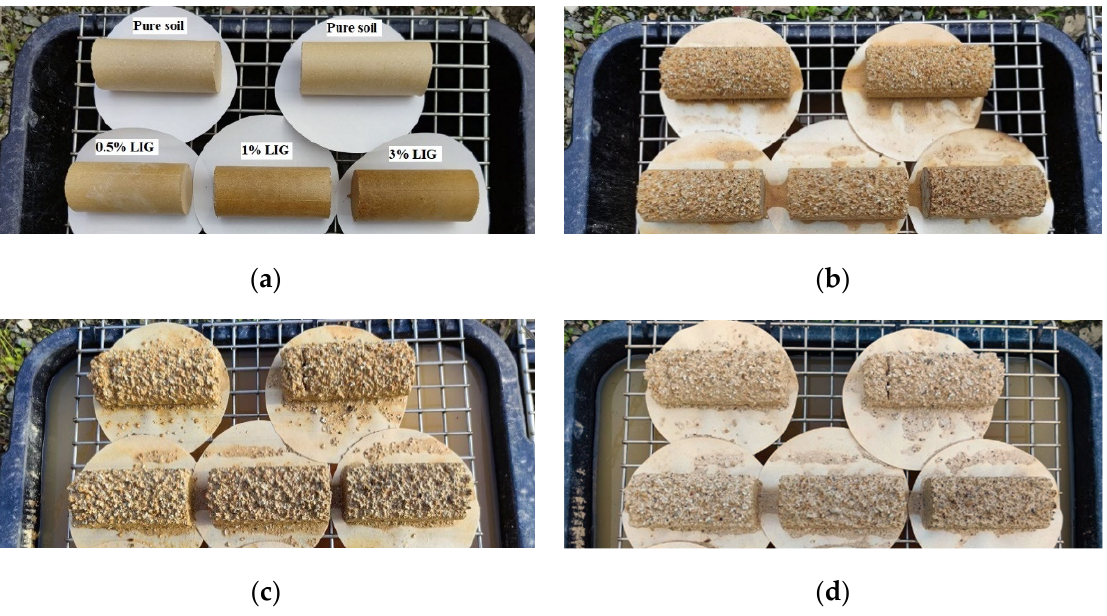
Figure 10. Soil mass loss after exposure to atmospheric conditions. 3.6. SEM Analysis SEM images of untreated and 3% LIG-treated soil are presented in Figure 11. The structure of soil changed due to lignin additive. The structure of pure soil has changed